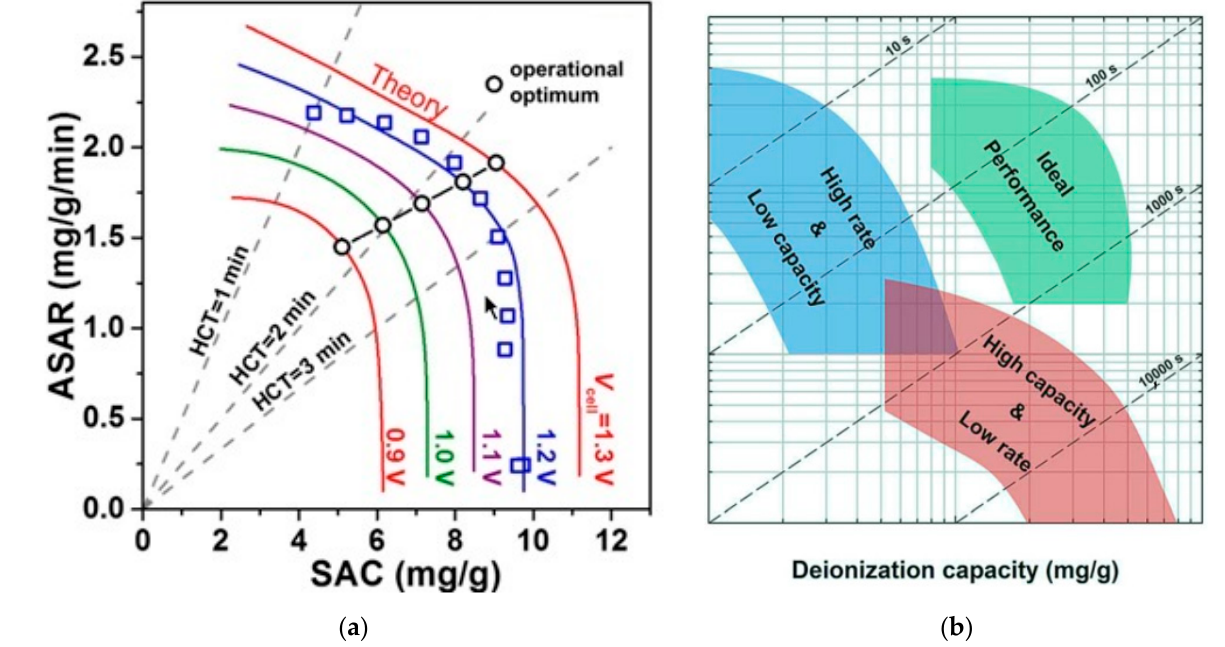
Figure 19. Kim-Yoon diagram for the average rate of adsorbed salt versus salt removal capacity. ( a ) Optimal points of different applied voltages. Reproduced from Ref. [78], with permission from the Royal Society of Chemistry. ( b ) Optimal areas for ASAR and SAC variables. Reproduced from Ref. [143]. with permission from the Royal Society of